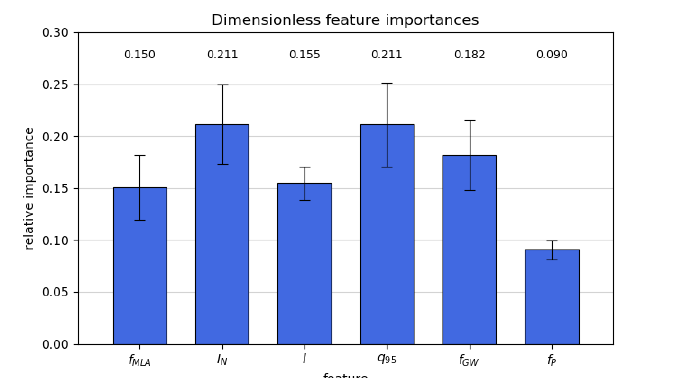
Figure 9. Relative importance of the different dimensionless input features, as obtained from the random forest